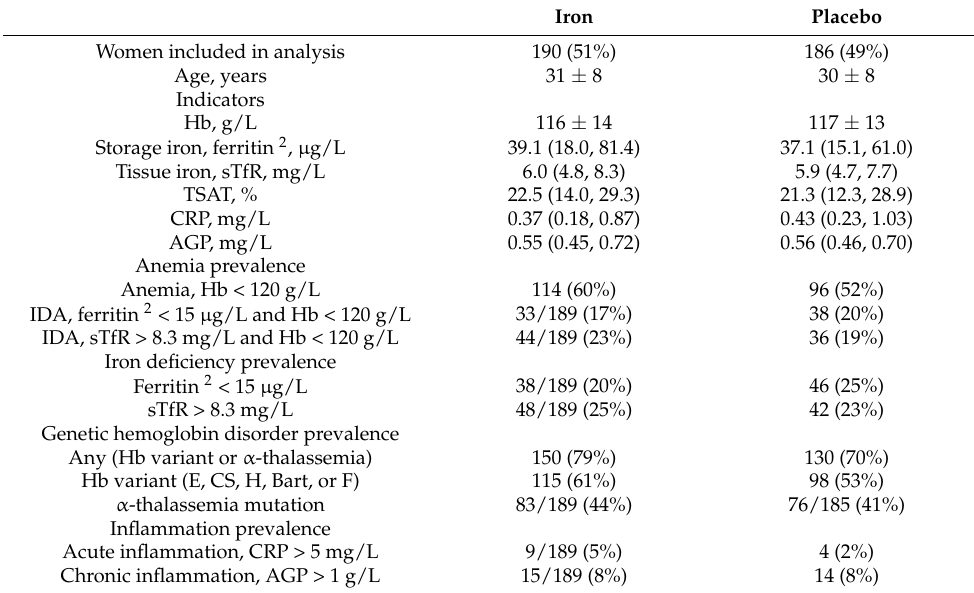
Table 1. Baseline indicators and prevalence rates for women by supplement group 1 . Iron